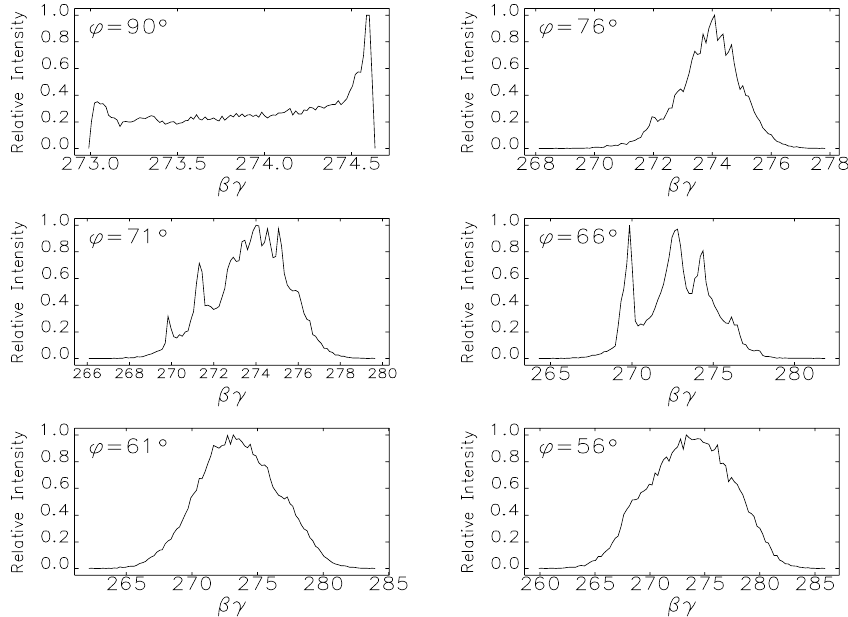
FIG. 9. (Color) Momentum distributions at the exit of the chicane for various precompressor phase settings.